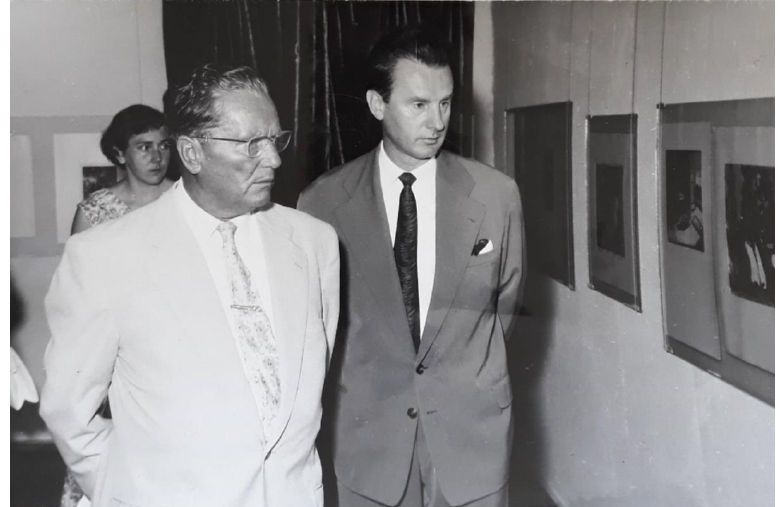
Figure 2. 3rd International Exhibition of Graphic Arts, Moderna galerija, Ljubljana, 1959 President of the Federative People’s Republic of Yugoslavia Josip Broz Tito visiting Moderna galerija, 23.7.1959 (from left: Josip Broz Tito, Zoran Kržišnik), © Moderna galerija.